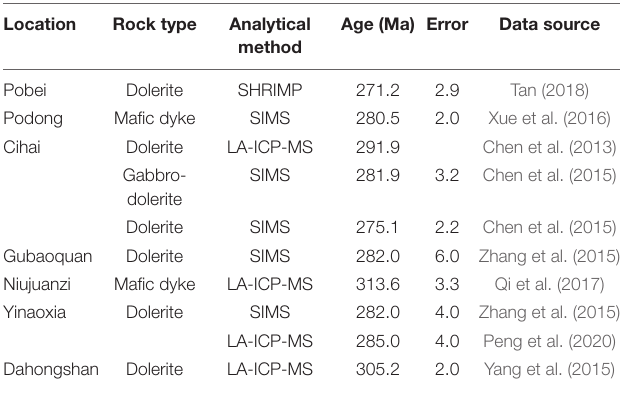
TABLE 3 | Compiled ages of dolerite dykes in Beishan area.